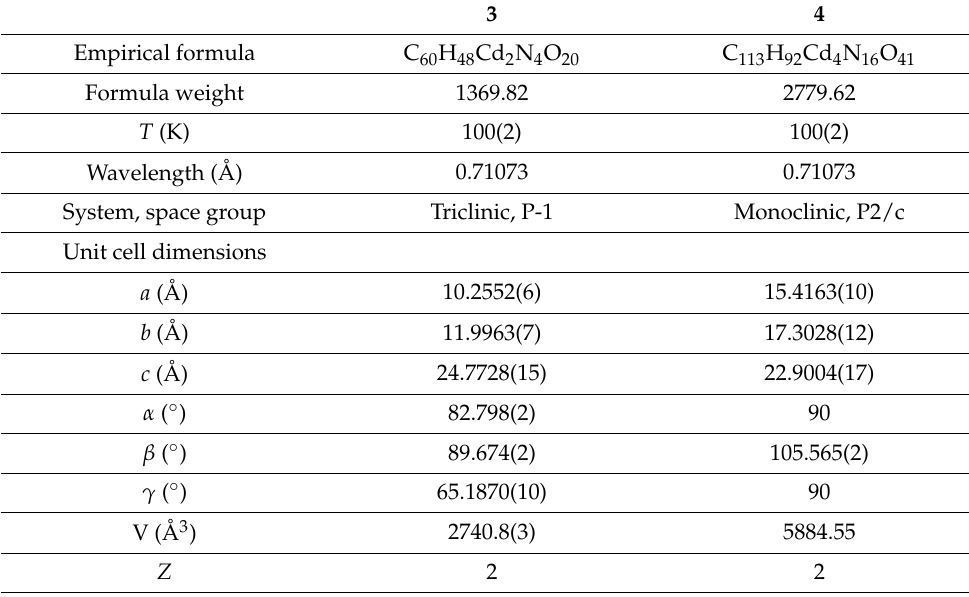
Table 10. Crystal structure refinement parameters for 3 and 4